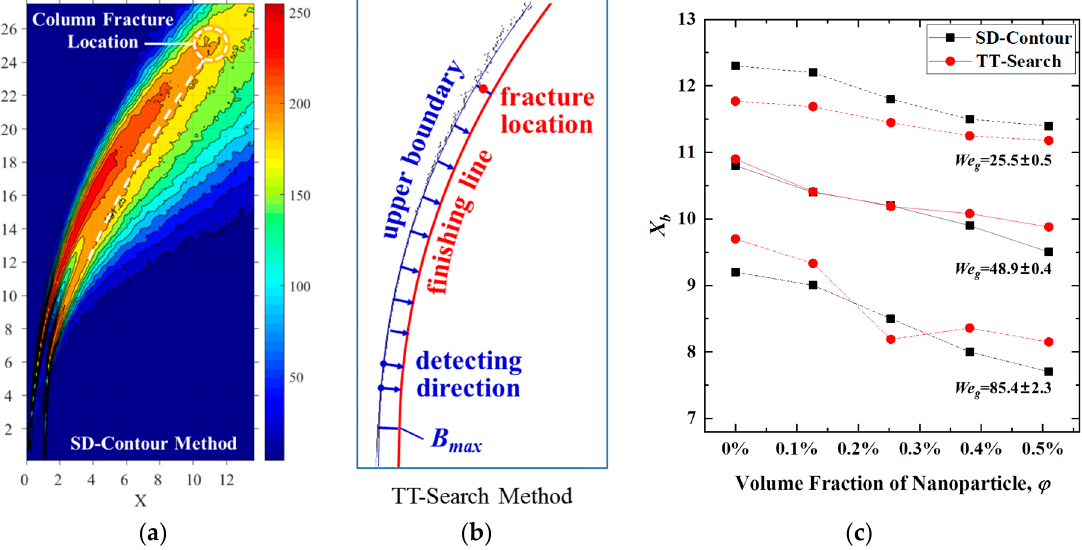
Figure 6. Image identification method for the column fracture location: ( a ) SD-contour method; ( b ) TT-Search method; ( c ) Comparison of processing results between the two methods.